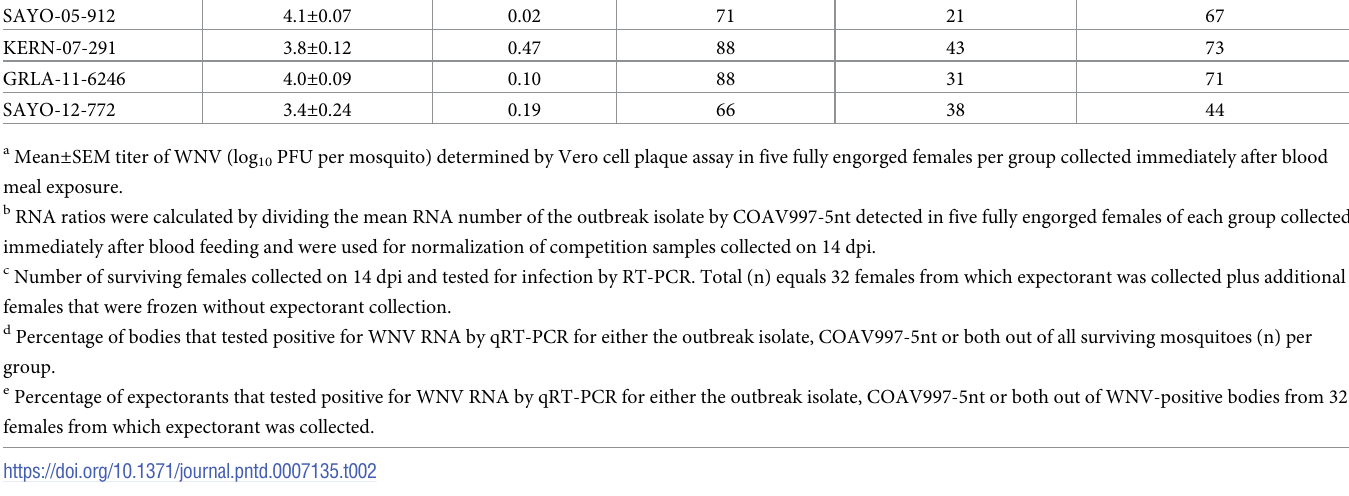
evaluated for the presence of clinical signs until 14 days post infection (dpi), with 0.1 mL of blood collected daily by jugular venipuncture between 1–7 dpi and upon termination of the study at 14 dpi. HOFIs were euthanized by placement in a CO chamber when they were 2 found moribund or at termination of the study on 14 dpi. Mosquito bodies were homogenized twice for two minutes at 24 Hz using a Tissue Lyser (Qiagen, USA) and the suspension clarified by centrifugation at 5,000 × g and 4˚C for 10 min- utes. Culex tarsalis expectorants were amplified by one passage in Vero cell culture to enhance detection of low amounts of viral RNA. Nucleic acids were extracted from HOFI sera, mos- quito homogenates and amplified expectorants using a MagMAX-96 Viral RNA isolation Kit (Applied Biosystems, USA). A previously described qRT-PCR assay was utilized for specific detection and quantification of viral RNA in mixed competition samples based on five nucleo- tide polymorphisms in the envelope gene region of COAV997-5nt [24]. Outbreak isolates were detected using primers previously described [27]. Infectious titers in mosquito blood meals and HOFI inocula were determined using plaque assay titration on Vero cells [12]. GraphPad Prism version 7 (La Jolla, CA) was used for statistical analysis and data plotting.